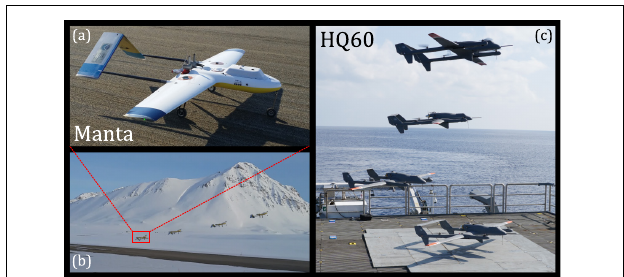
FIGURE 1 | (a) Manta UAV with the LDEO RAD Payload (b) performing a wheel-takeoff in Ny-Ålesund, Svalbard in May 2015. (c) Latitude Engineering HQ-60 performing a vertical takeoff from the deck of the SOI R/V Falkor in the South Pacific Ocean in November 2016. The photographs in (b) and (c) are composites built from multiple video stills.